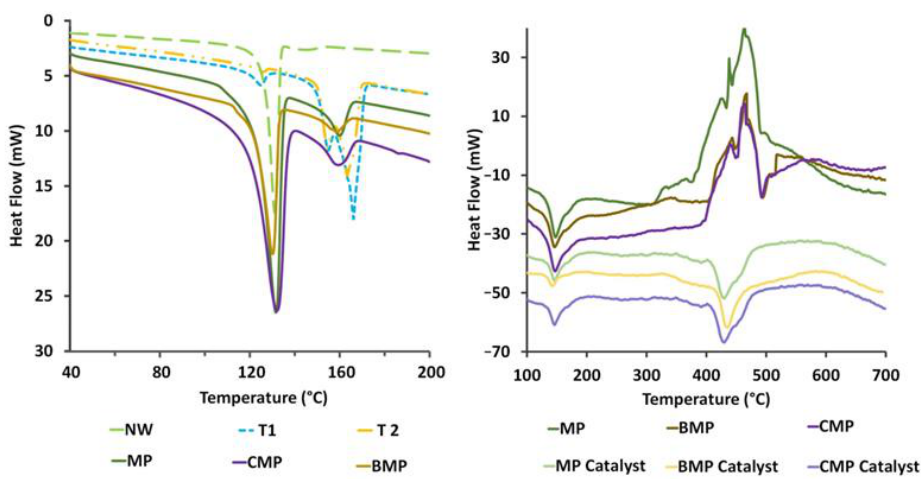
Figure 3. ( left ) DSC thermograms of NW, T1, T2, MP, BMP, and CMP and ( right ) DTA thermograms of MP, BMP, CMP, MP-catalyst, BMP-catalyst, and CMP-catalyst. Table 5. Average DSC melting peaks and percent crystallinity of NW, T1, T2, MP, BMP, and CMP